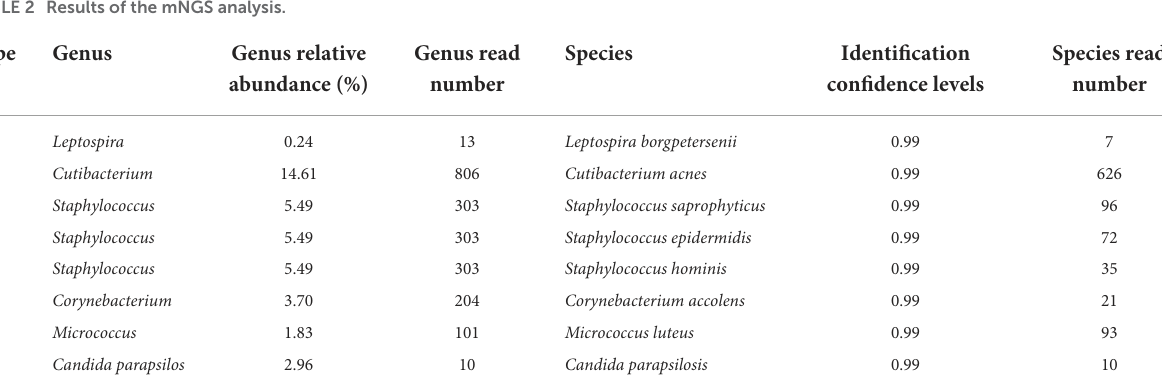
TABLE 2 Results of the mNGS